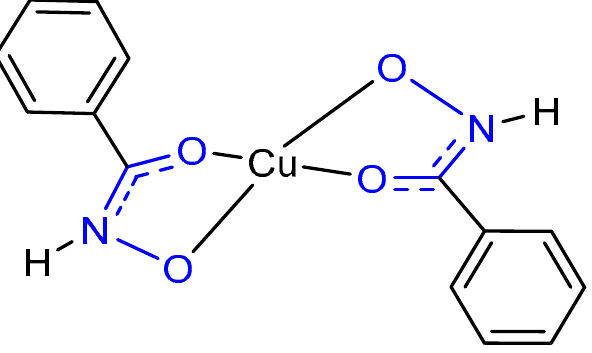
Figure 2. Hydroxamic acid ability to chelate metal ions such as the copper ions.